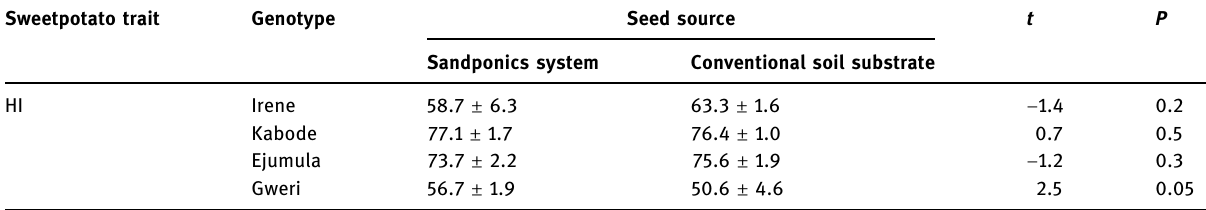
Table 6: Mean comparison of HI due to the e ff ect of interaction between seed source and genotype Sweetpotato